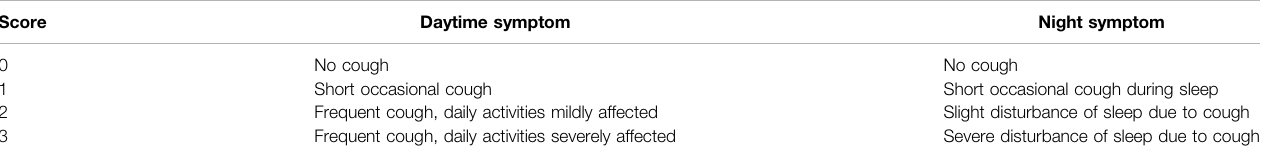
TABLE 3 | Cough symptom